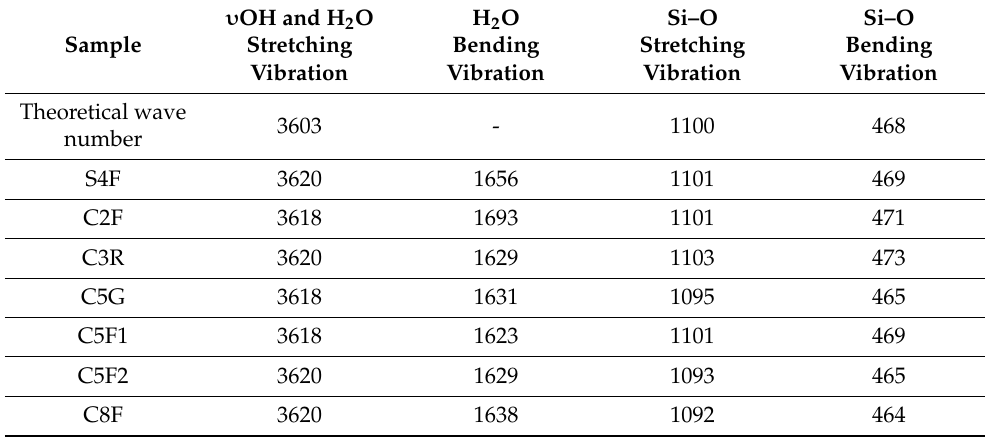
Table 3. The infrared absorption frequency of coal-measure kaolinite rocks (cm − 1 ). υ OH and H 2 Sample